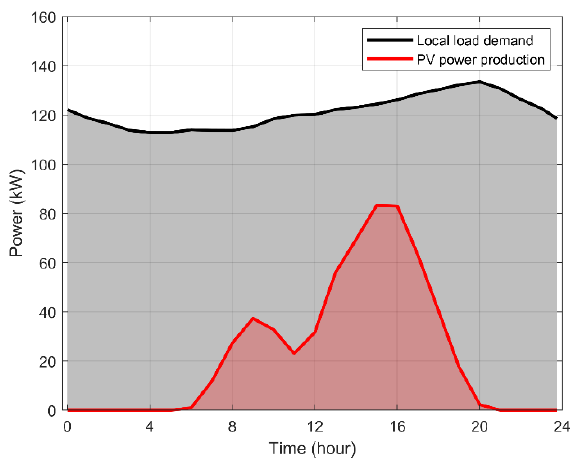
Figure 7. Variation of local load demand and PV power production.